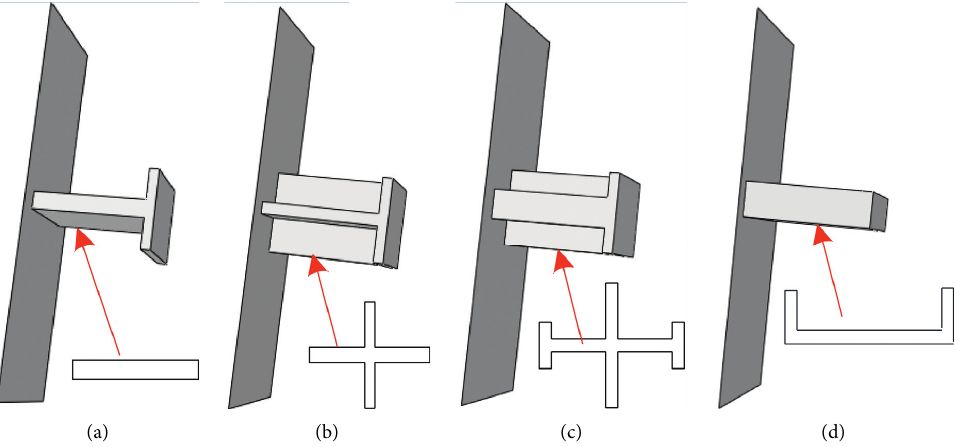
Figure 9: Shear connector configurations: (a) linear type; (b) cross type; (c) cross bilinear type (CB type); (d) channel